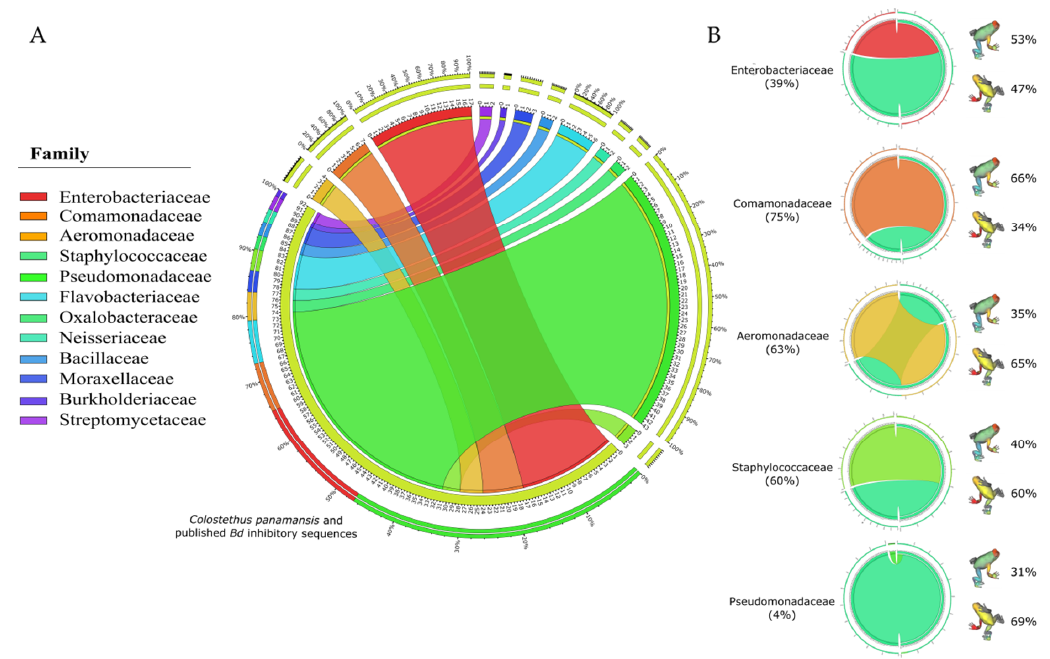
Figure 6. Relative abundances of 791 bacterial sequences from C. panamansis and anti- Bd published sequences. ( A ) Relative abundance of 16S rRNA sequences from C. panamansis and anti- Bd sequences from published databases based on their bacterial family. ( B ) Comparison between the five most abundant bacterial families in C. panamansis and Bd -inhibitory sequences (light green) and the distribution of isolates based on the coronal plane in C. panamansis is also displayed.